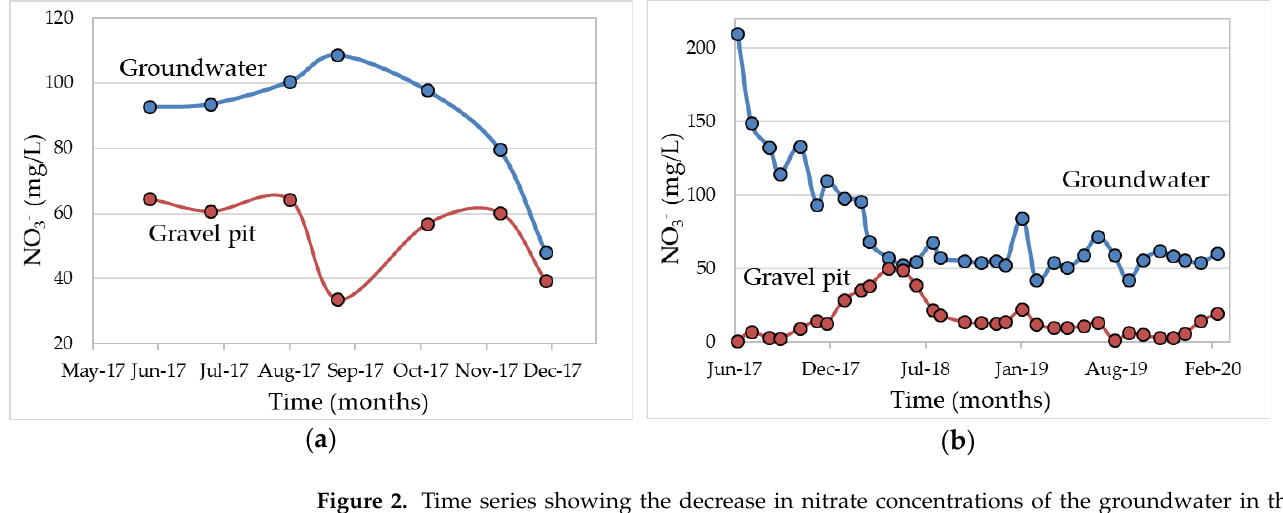
Figure 2. Time series showing the decrease in nitrate concentrations of the groundwater in the ( a ) active gravel pit and ( b ) inactive gravel pit.